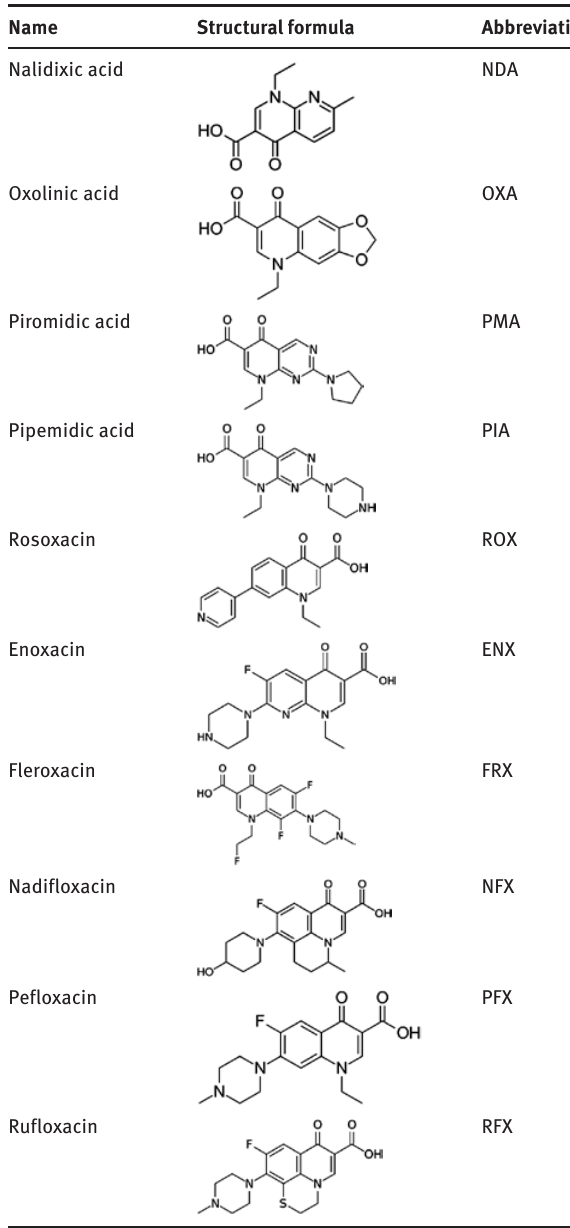
Table 1: Chemical structure of the selected